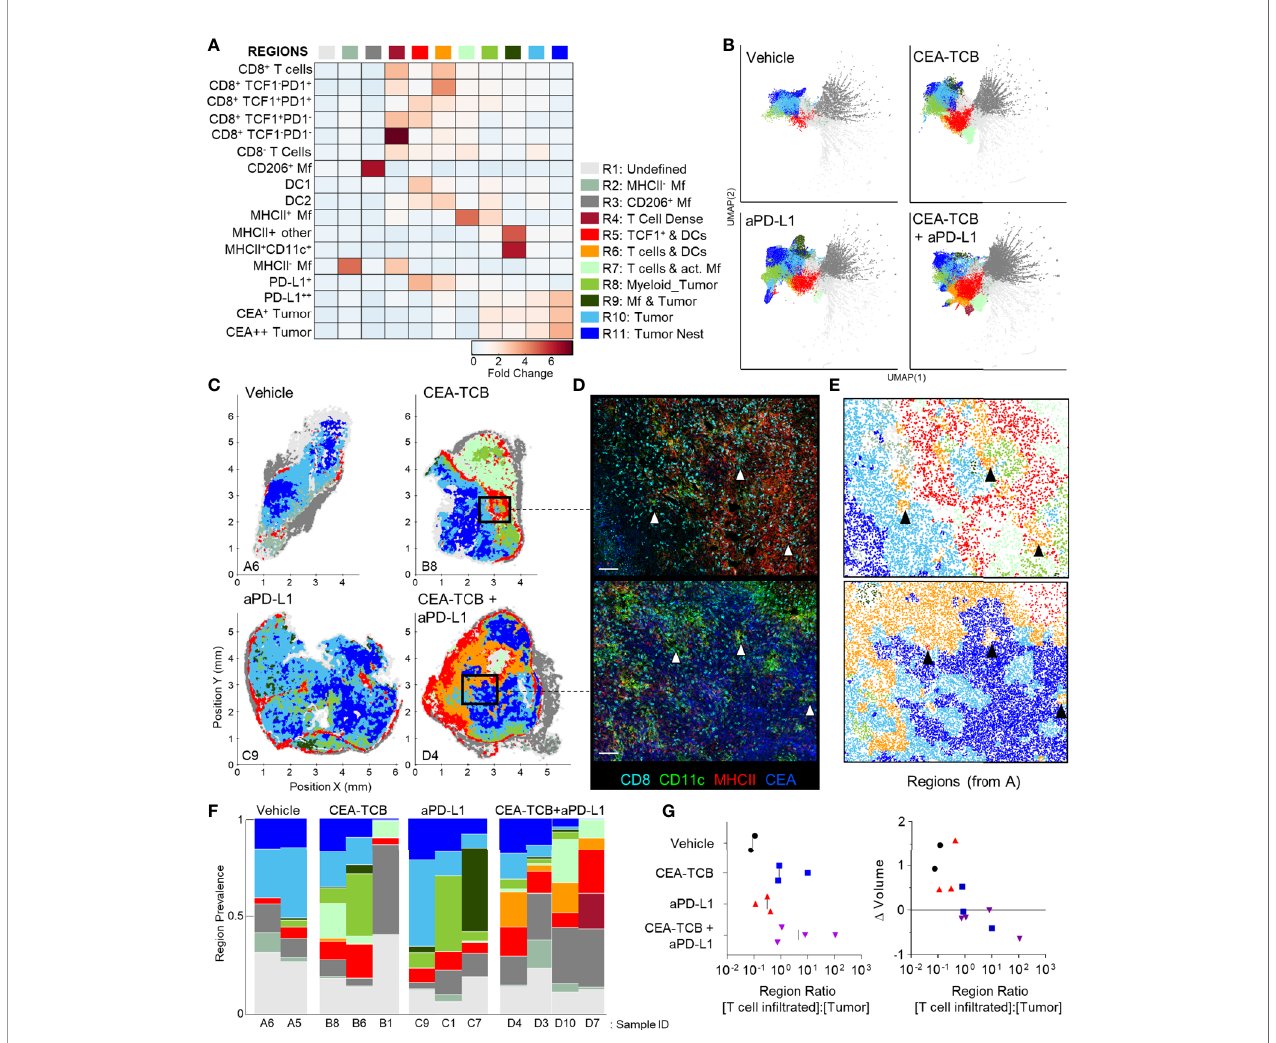
FIGURE 3 | CytoMAP based regional analysis of the MC38-CEA tumor microenvironment. (A) Spatial neighborhoods were clustered into regions and plotted on a region heatmap. Plot displays fold change of object density per neighborhood within the indicated regions across all samples. (B) UMAP plots of the color-coded neighborhoods from each treatment group displaying the heterogeneity in the tissue regions. (C) Plots of the positions of all neighborhoods for select samples from each treatment group, color coded by region classi fi cation de fi ned in panel (A, D) Multiplexed confocal regions of interest boxed in panel (C) Arrows highlight select niches enriched in T cell and DCs. Scale bar represents 100 µm. (E) Plots showing the individual CytoMAP objects for the regions of interest shown in panel (D) , color-coded by region classi fi cation de fi ned in panel (A, F) Region prevalence for each sample (columns) within the treatment groups. (G) Ratio of immune in fi ltrated regions to immune excluded regions (left). Region ratio plotted versus fold change in tumor volume after the initiation of therapy. All the above plots were generated as described in Figure S1A ; n=2 for control, n=3 for CEA-TCB and aPDL1 and n=4 for CEA-TCB+aPD-L1